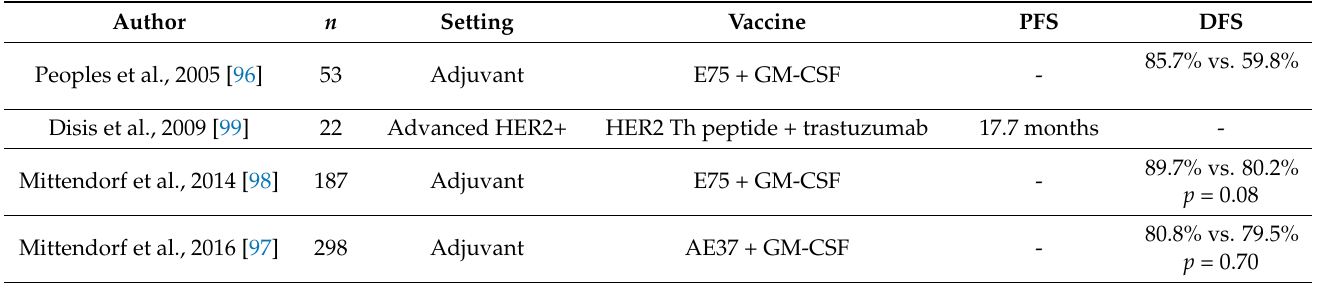
Table 7. Vaccination trials in breast